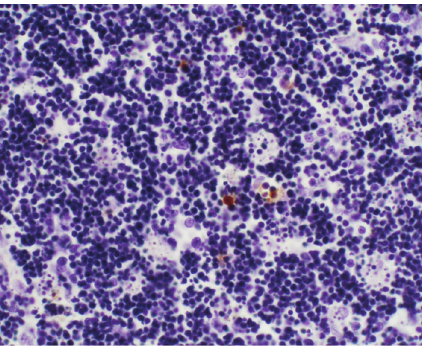
Figure 7: Sham operation group: 12 hours; Caspase-3 × 200.